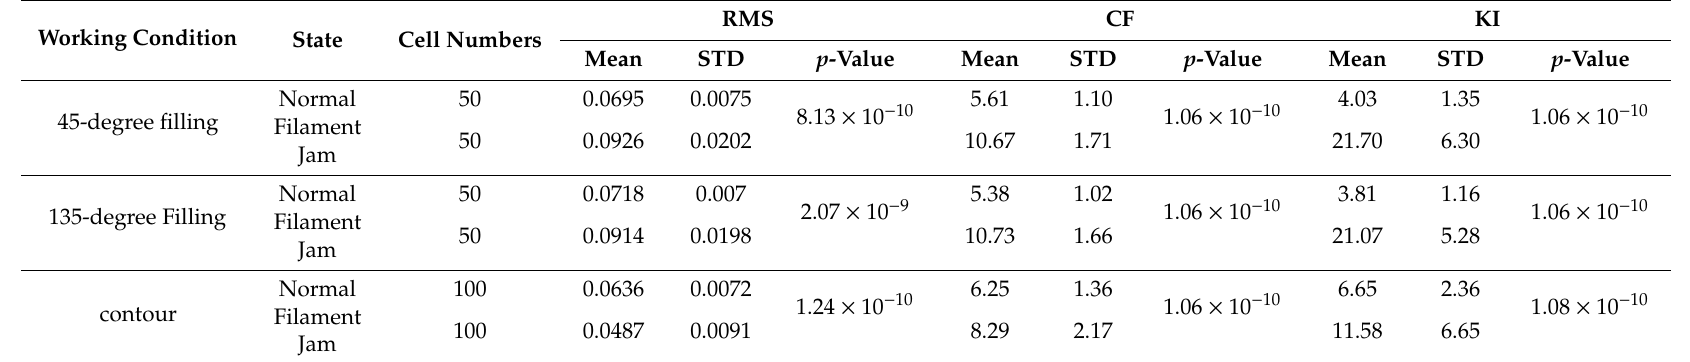
Table 2. The mean and STD values for RMS, CF, and KI, and p -values of all pairs for normal and filament states. Working